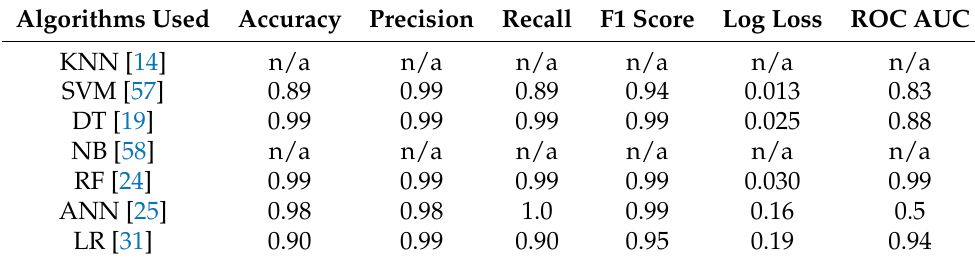
Table 27. OS scan weighted classes